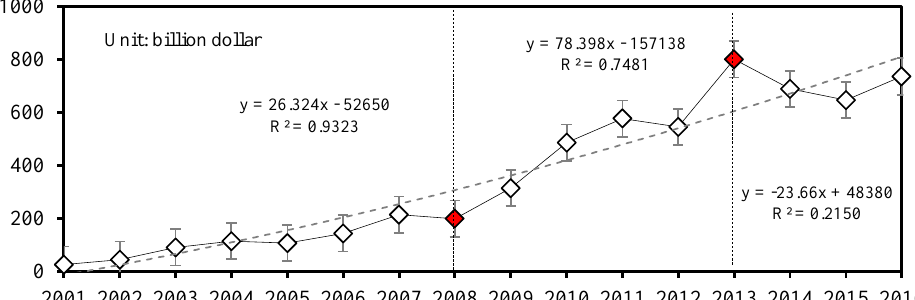
Figure 4. The trend of annual land finance in Stage 1 (2001 – 2008), Stage 2 (2009 – 2012), and Stage 3 (2013 – 2016), respectively.